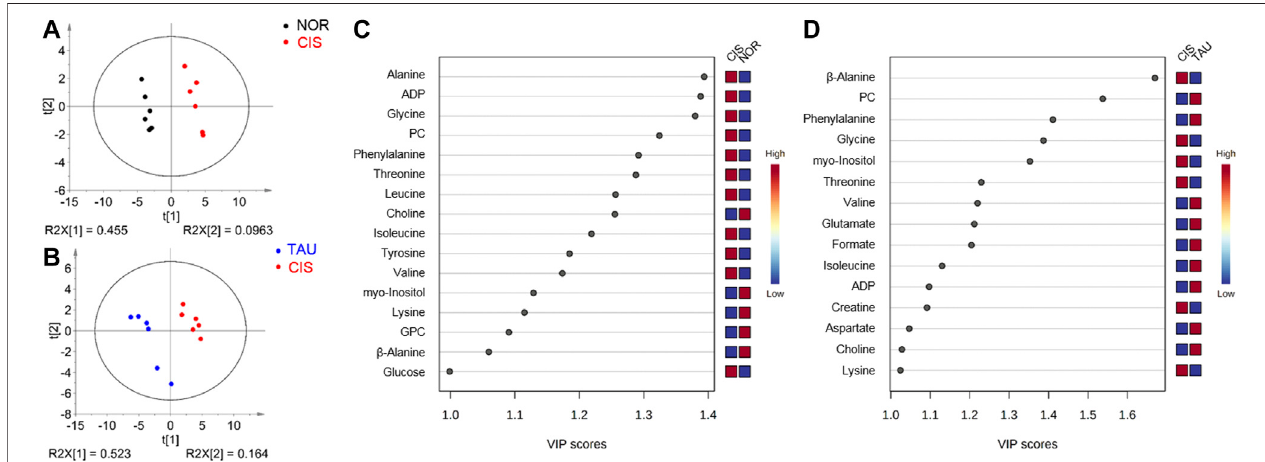
FIGURE 6 | PLS-DA analysis for identifying signi fi cant metabolites primarily responsible for the discrimination of metabolic pro fi les among the NOR, CIS, and TAU groups of C2C12 myoblasts. (A, B) PLS-DA score plots for CIS vs. NOR (A) and TAU vs. CIS (B) . The ellipses indicate the 95% con fi dence limits. (C, D) VIP score- ranking plots of signi fi cant metabolites identi fi ed from the PLS-DA models of CIS vs. NOR (C) and TAU vs. CIS (D) . Signi fi cant metabolites were identi fi ed with VIP > 1.